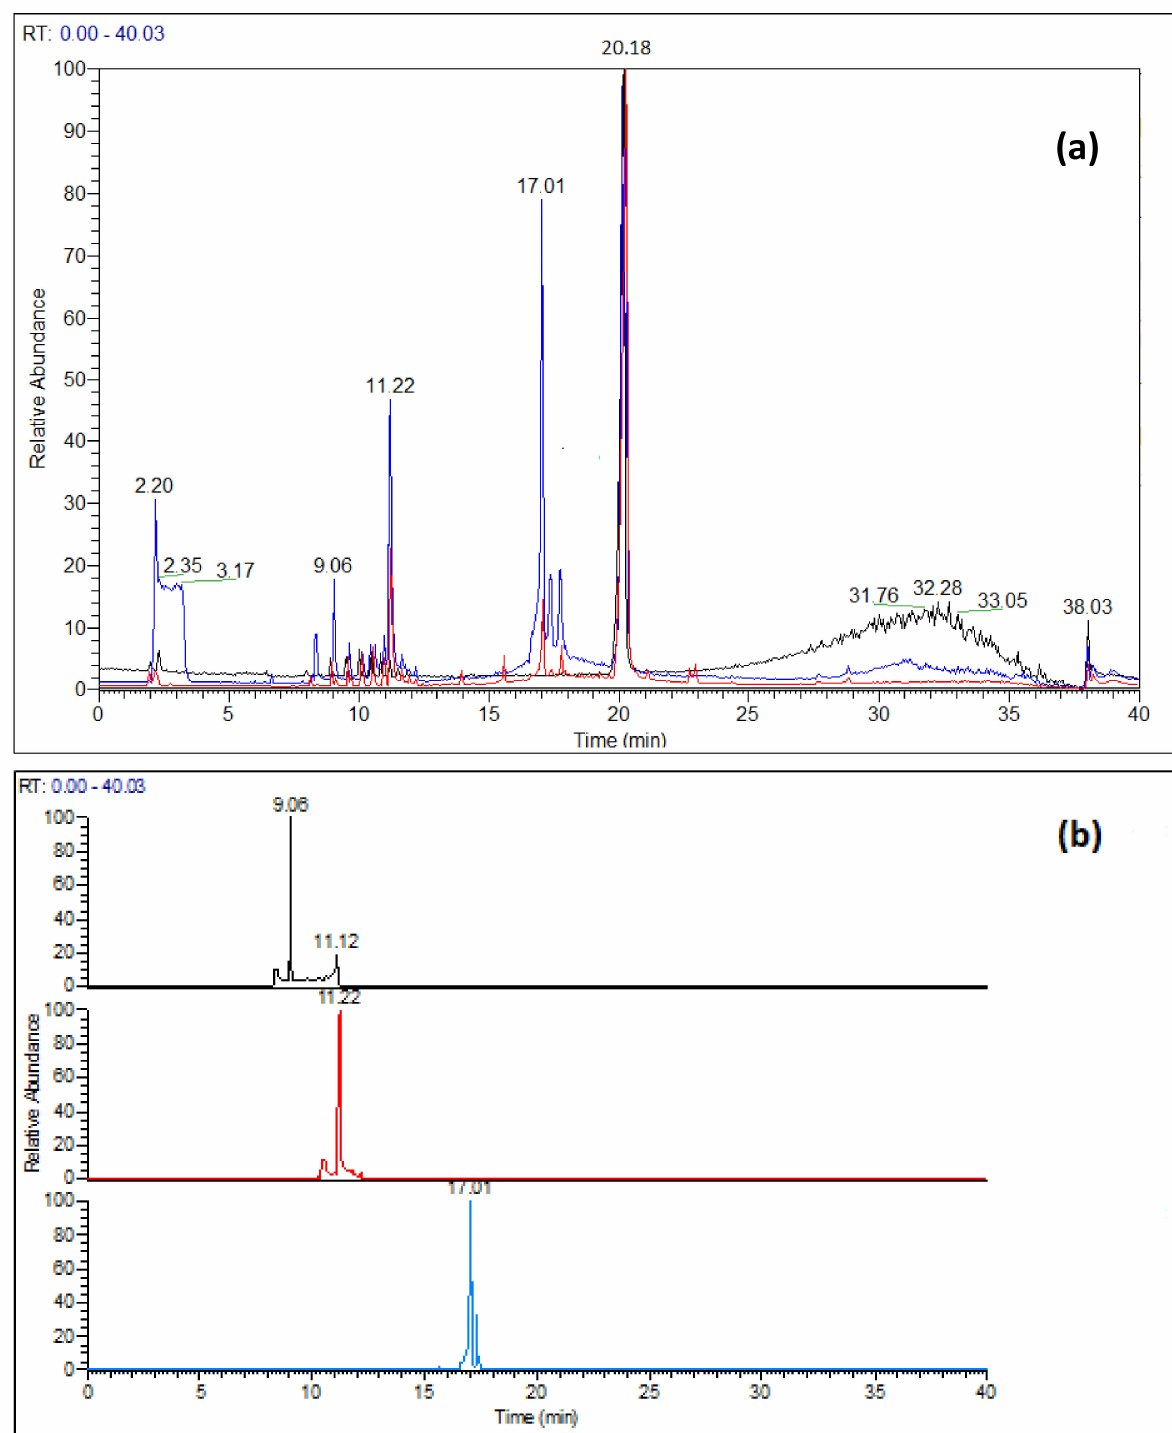
Figure 1. ( a ) LC-HR-MS full scan chromatograms of nirmatrelvir: standard solution (black), after 3 h at pH = 13 ± 0.2 (blue), after one week at pH = 1 ± 0.2 and at 40 ◦ C (red). ( b ) Extracted ion chromatograms obtained from the full scan chromatogram recorder after 3 h at pH = 13 ± 0.2: black m/z [421.5 – 422.5] uma, red: m/z [403.5 – 404.5] uma, light blue: m/z [517.5 – 518.5]